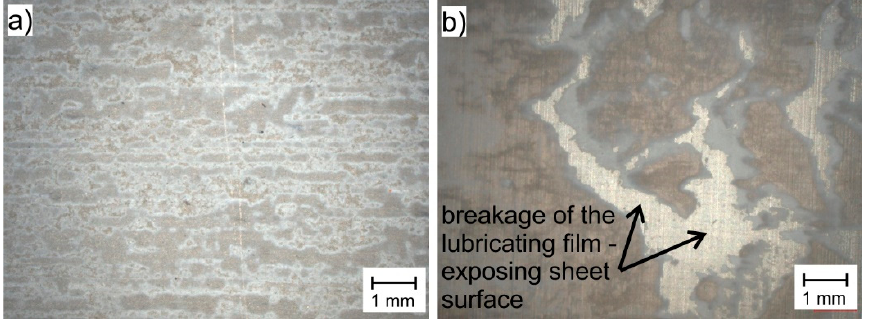
Figure 5. View of sheet surface with layer of lubricant No 2 sprayed on: ( a ) Grade 2 titanium sheet; ( b ) Grade 5 titanium sheet after strip drawing test.